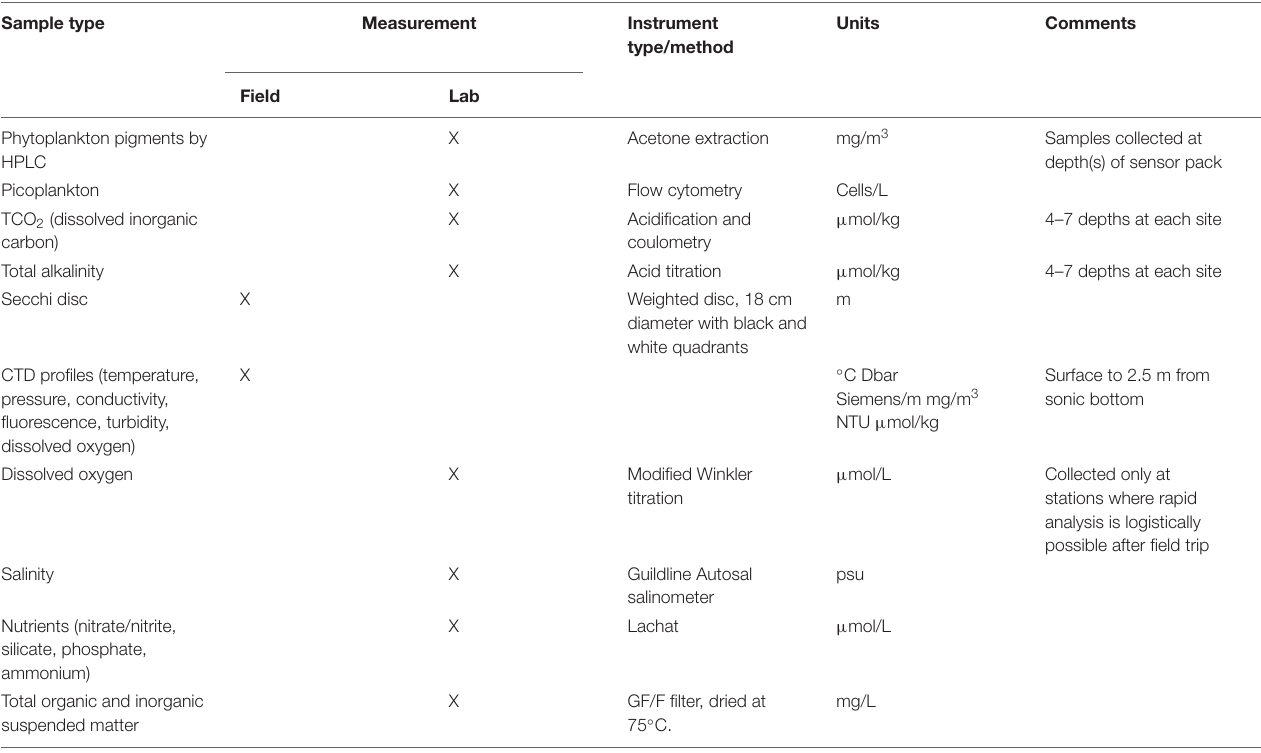
TABLE 2 | Parameters measured in situ , or sampled at National Reference Station sites, with instrument type or method, and